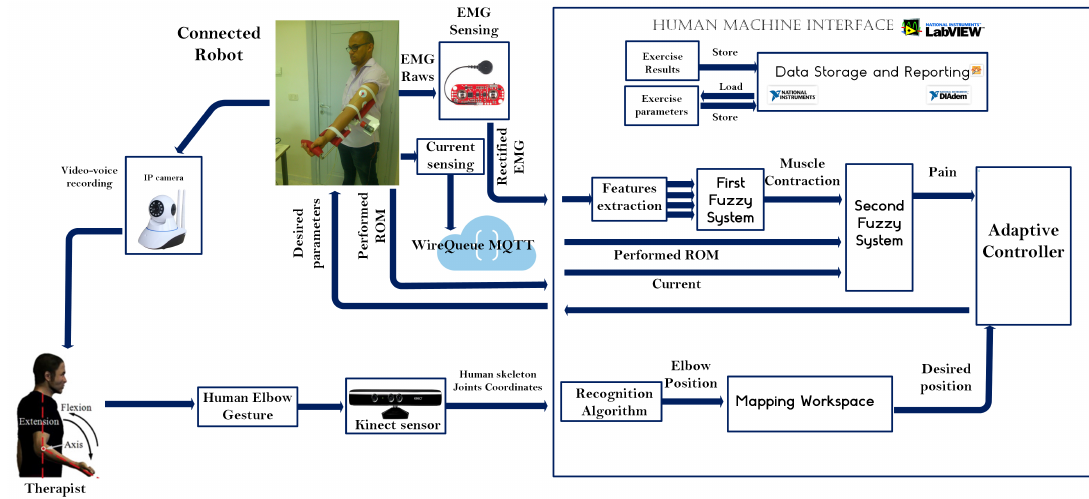
Figure 1. Control architecture